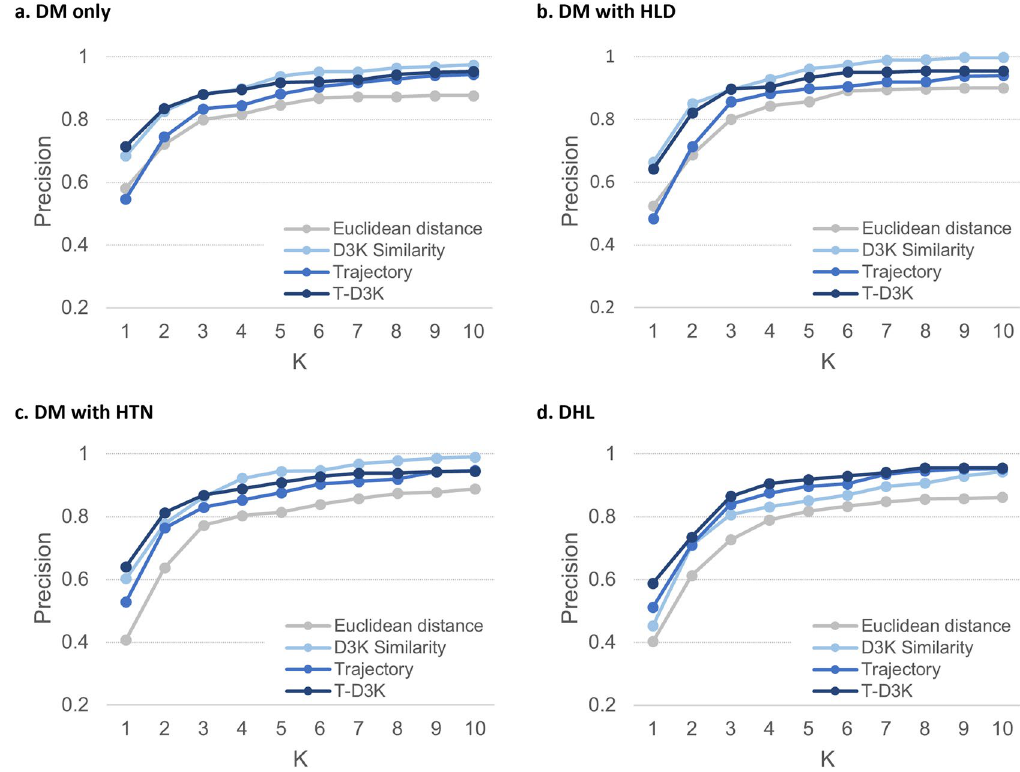
Figure 3. Precision for four groups of